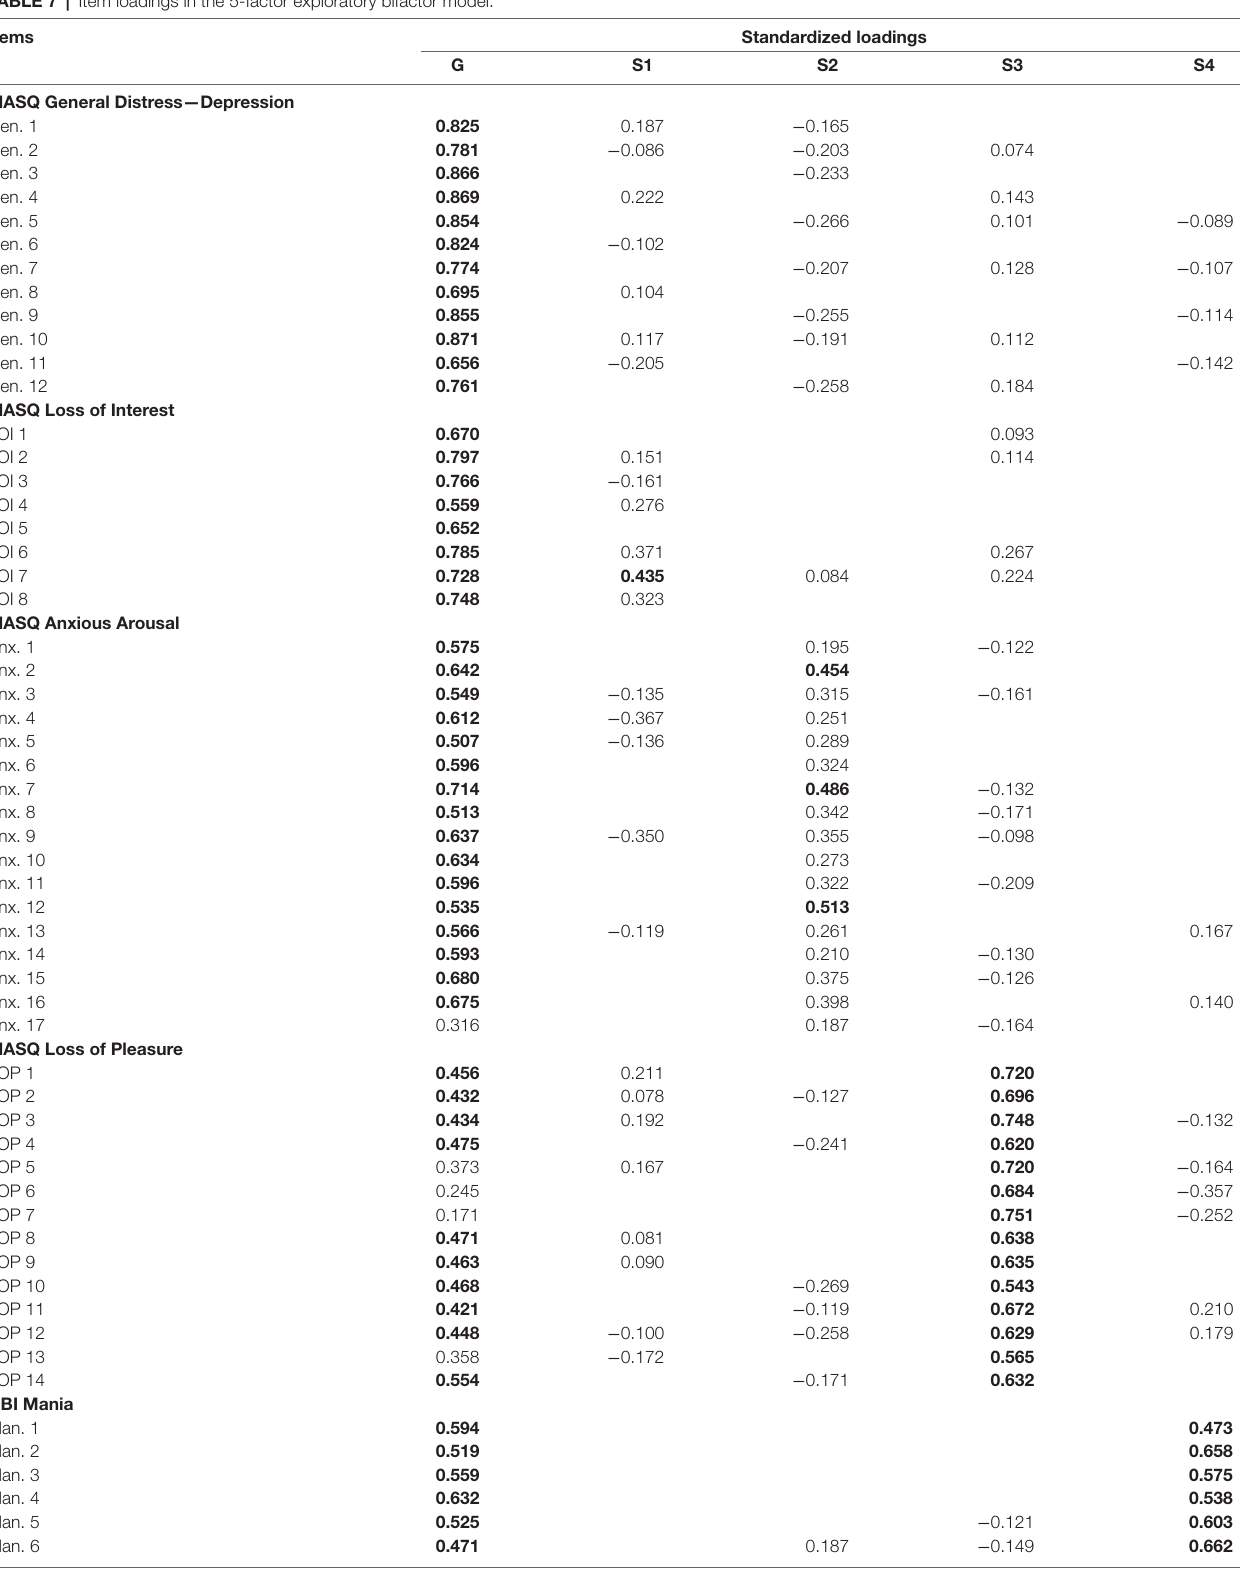
TABLE 7 | Item loadings in the 5-factor exploratory bifactor